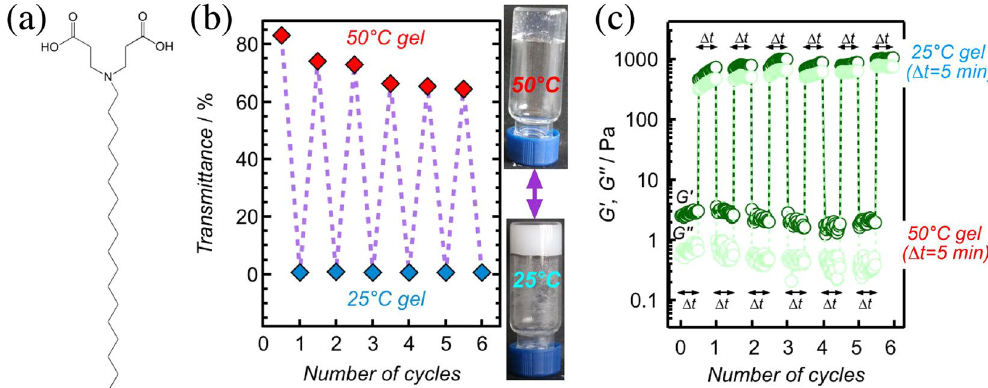
Figure 1. ( a ) Chemical formula of C18ADPA. ( b ) Pictures of 2% pH = 5.37 hydrogel at 25 °C and 50 °C together with its transmittance data during successive cooling-heating cycles. ( c ) Rheological data during successive cooling-heating cycles (strain = 0.5%; angular frequency of ω = 10 rad/s). In ( b ) and ( c ), the waiting time after a temperature increase was about 2 min and after a temperature decrease was about 5 min.